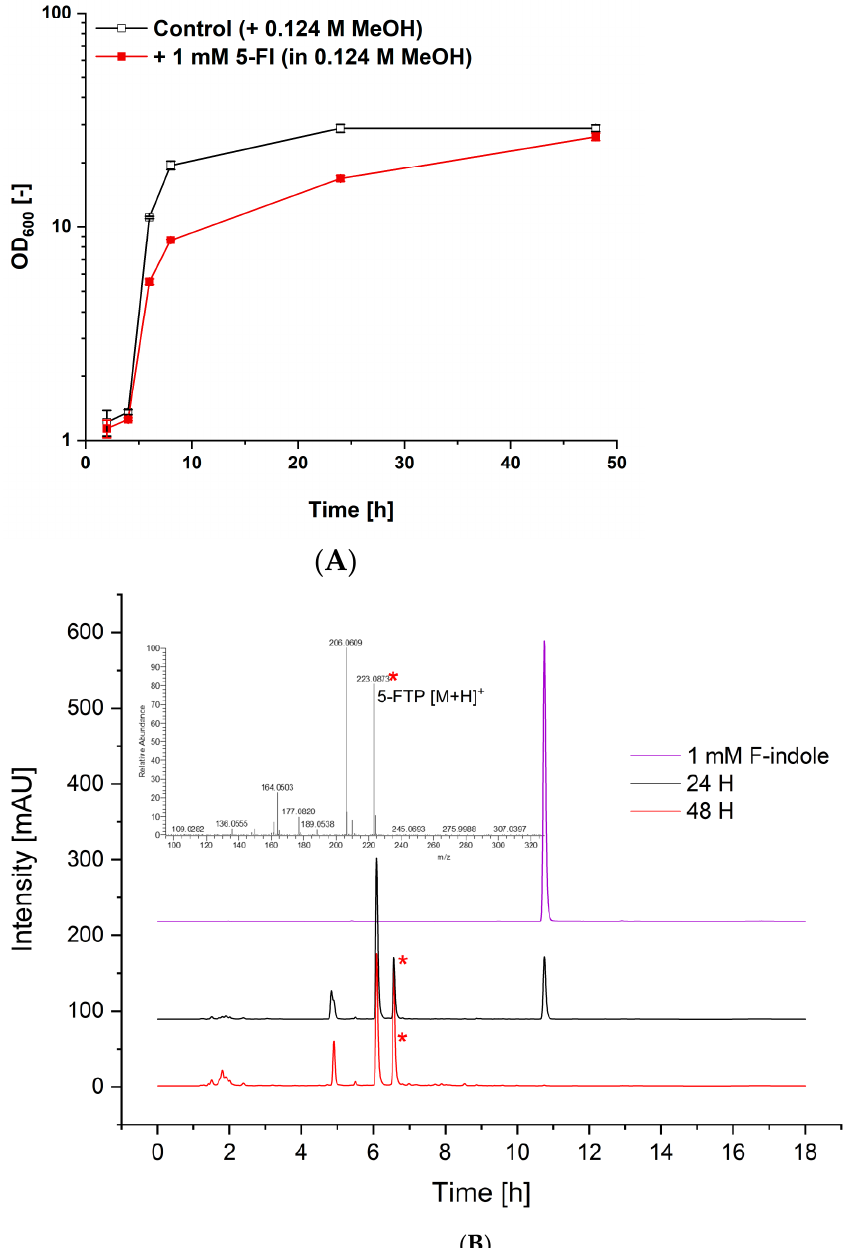
Figure 7. ( A ) Growth of SER2 (pSdS- trpB ) cultivated with or without 1 mM 5-FI. Data are means and errors of three cultivations. ( B ) Conversion of 5-FI to 5-FTP by HPLC and MS analysis . The degree of conversion of 1 mM 5-FI to its corresponding 5-FTP was determined by the disappearance of 5-FI peak during HPLC analysis [retention time (RT) = 10.8 min] and appearance of the peak at RT = 6.6 min. Structural identity of the peak at RT = 6.6 min was confirmed by LC–MS analysis. Mass spectrum showed a clear peak (red asterisk) with a mass of 223.08045, which corresponds to 5-FTP [M+H] + . Exemplary data from three independent cultivations are given.